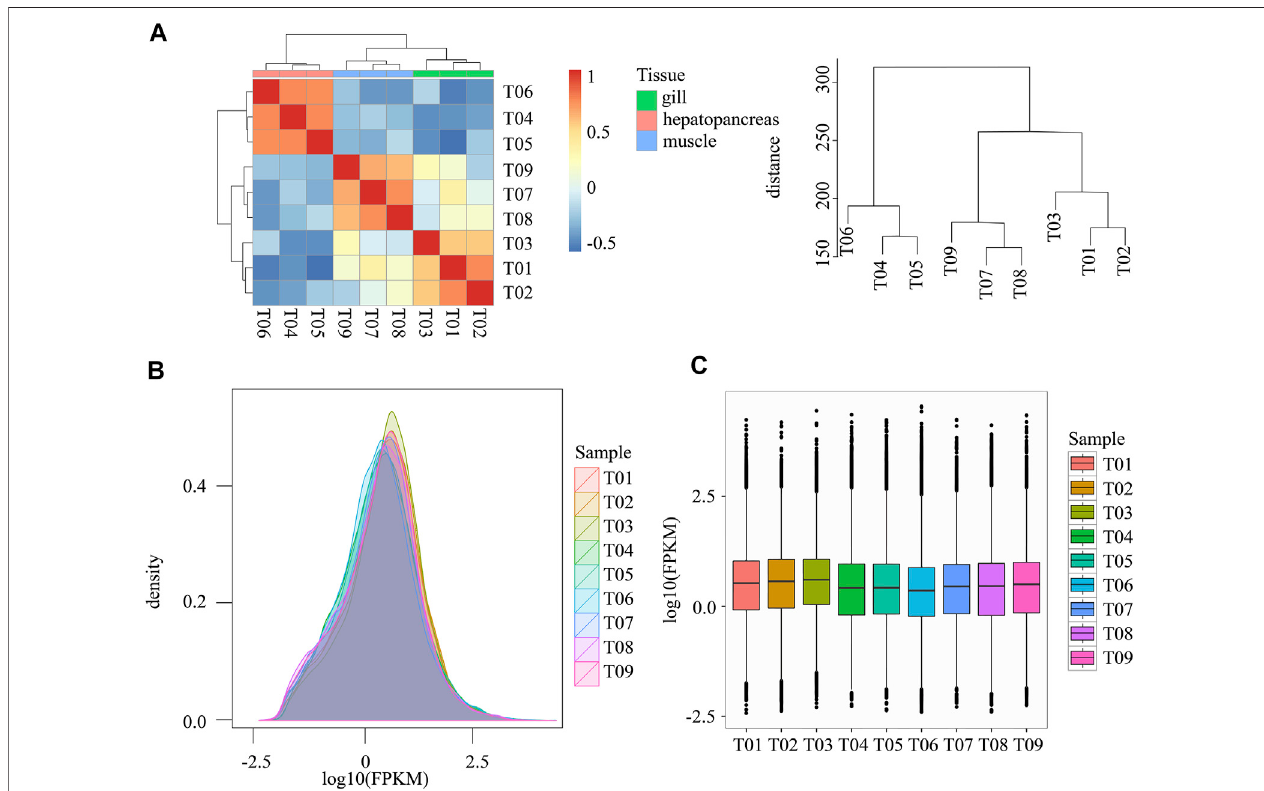
FIGURE 2 | Statistics regarding gene expression. (A) Hierarchical clustering and heat map of all samples. The right plot shows the clustering distance between samples. (B) Density distribution of expression values from all samples. (C) Box plot expression values from all samples. Note: FPKM: Fragments Per Kilobase of transcript per Million mapped reads. Samples T01-T03 belong to gill, T04-T06 belong to hepatopancreas, T07-T09 belong to muscle.